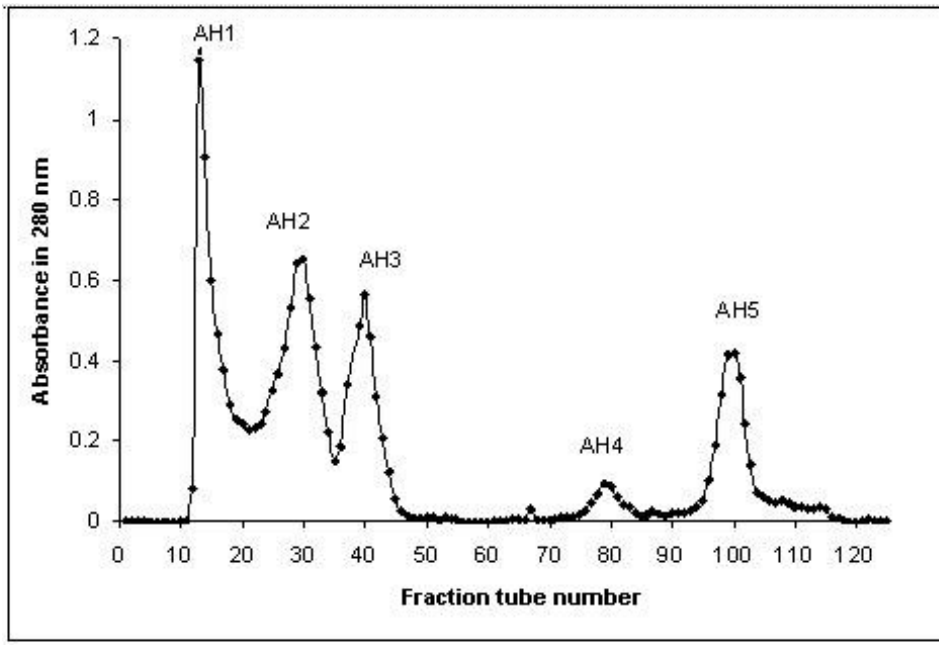
Figure 1. Crude venom of Agkistrodon halys (182.5 mg) was applied to Sephadex G- 50 column (3 x 150 cm) using buffer ammonium acetate 50 mM and pH 7.5. Flow rate was 60 mL/hour and 9-mL fractions per tube were